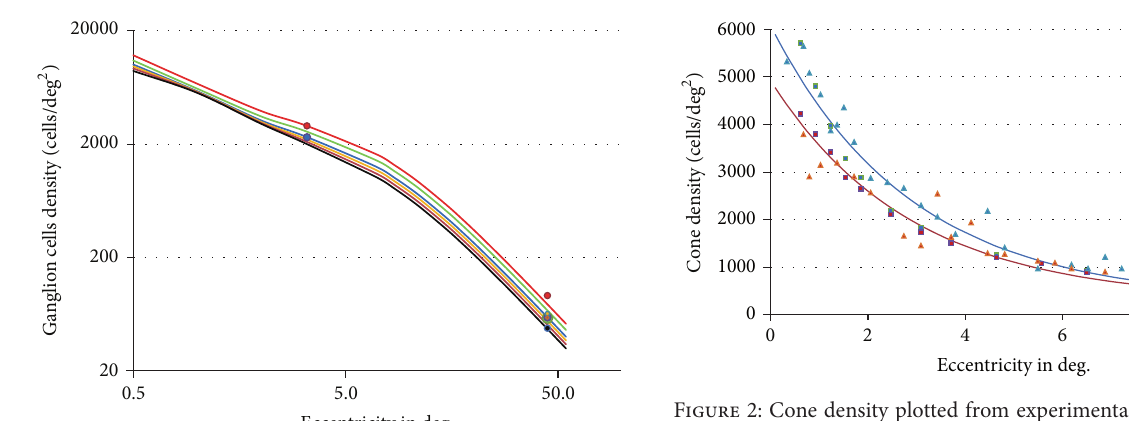
Figure 2: Cone density plotted from experimental data from [63] (blue: 22–35 years old; red: 50–65 years old) and [64] (blue: mean age 27.2; red: mean age 67.2) at various eccentricities. The continuous lines show the model proposed in (17) for 30 years (in blue) and 60 years (in